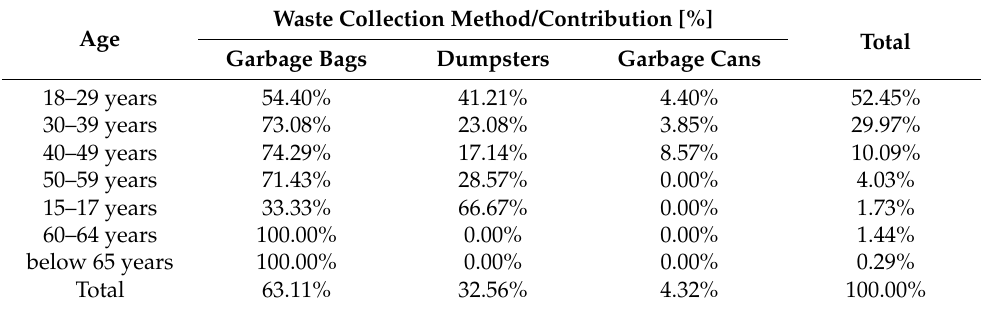
Table 3. Multi-partition table of method of waste collection taking into account respondents’